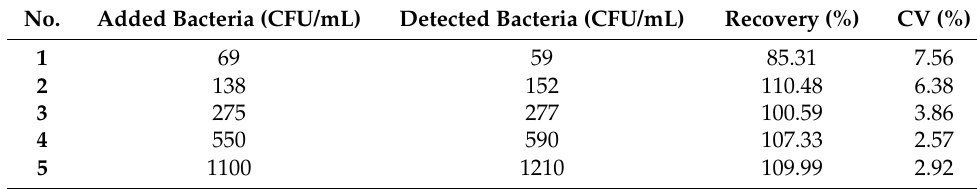
Table 1. Detection of Salmonella typhimurium in milk using this fluorescent